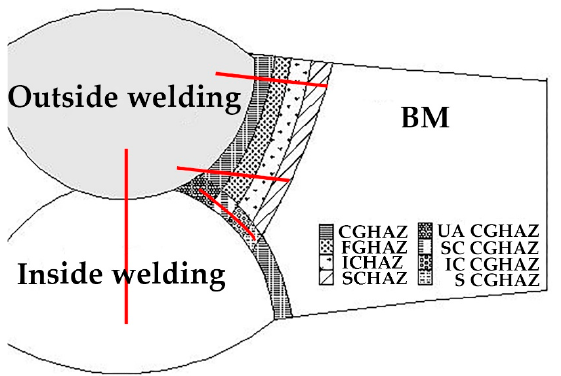
Figure 1. Schematic diagram of welded joint. The abbreviations in the figure are explained as follows: the base metal zone (BM), the coarse grain heat-affected zone (CGHAZ), the fine grain HAZ (FGHAZ), the intercritical HAZ (ICHAZ) and the subcritical HAZ (SCHAZ), unaltered CGHAZ (UA CGHAZ), supercritically reheated CGHAZ (SC CGHAZ), intercritically reheated CGHAZ (IC CGHAZ) and subcritically reheated CGHAZ (S CGHAZ).